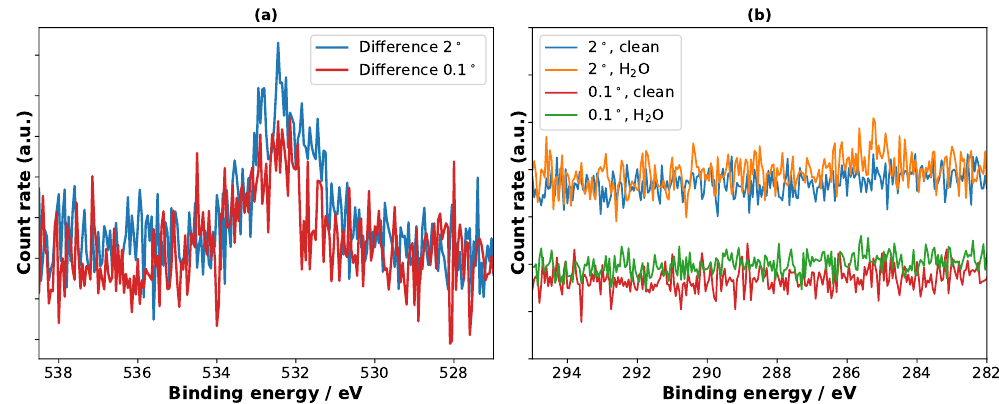
Figure 9: XPS (Al K α excitation, 60 ◦ take-off angle) for the two off-cuts before and after water exposure. (a) Difference spectra around the O 1s line. (b) Spectra around the C 1s